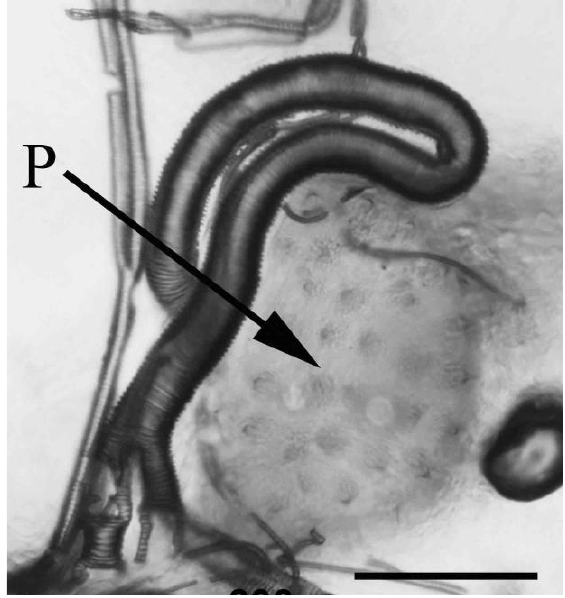
F IGURE 1. Cotton pollen (Gossypium hirsutum C. Linnaeus) (P) trapped within a boll weevil (Anthonomus grandis Boheman) gut. Bar = 100 micrometers.